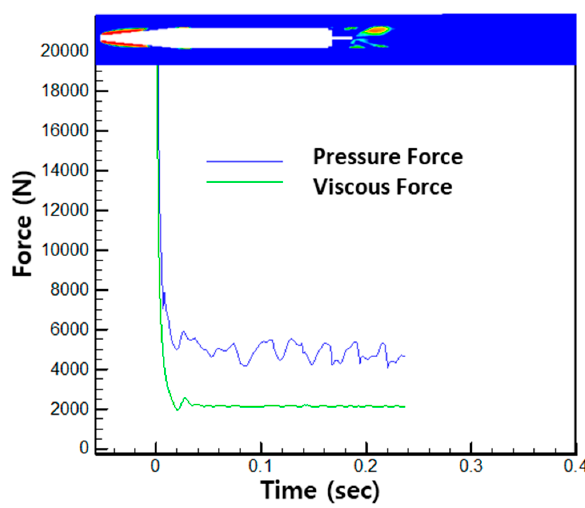
Figure 19. Analysis of drag unsteady state pressure force and viscous force at 70 m/s. Figure 18. Analysis of drag unsteady state pressure force and viscous force at 50 m/s. Appl. Sci. 2020 , 10 , x FOR PEER REVIEW